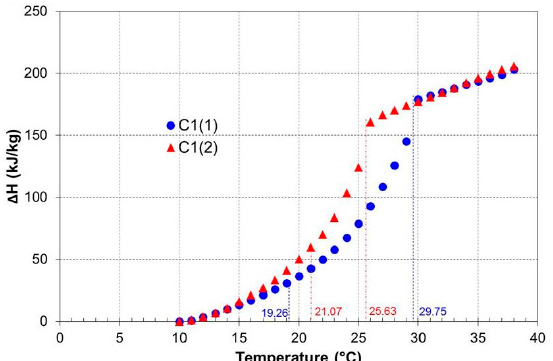
( d ) Figure 2. Heating and cooling cycles for all the samples, during the T-history method. ( a ): Sample C1(1); ( b ): sample C1(2); ( c ): sample C2(1); and ( d ): sample C2(2).